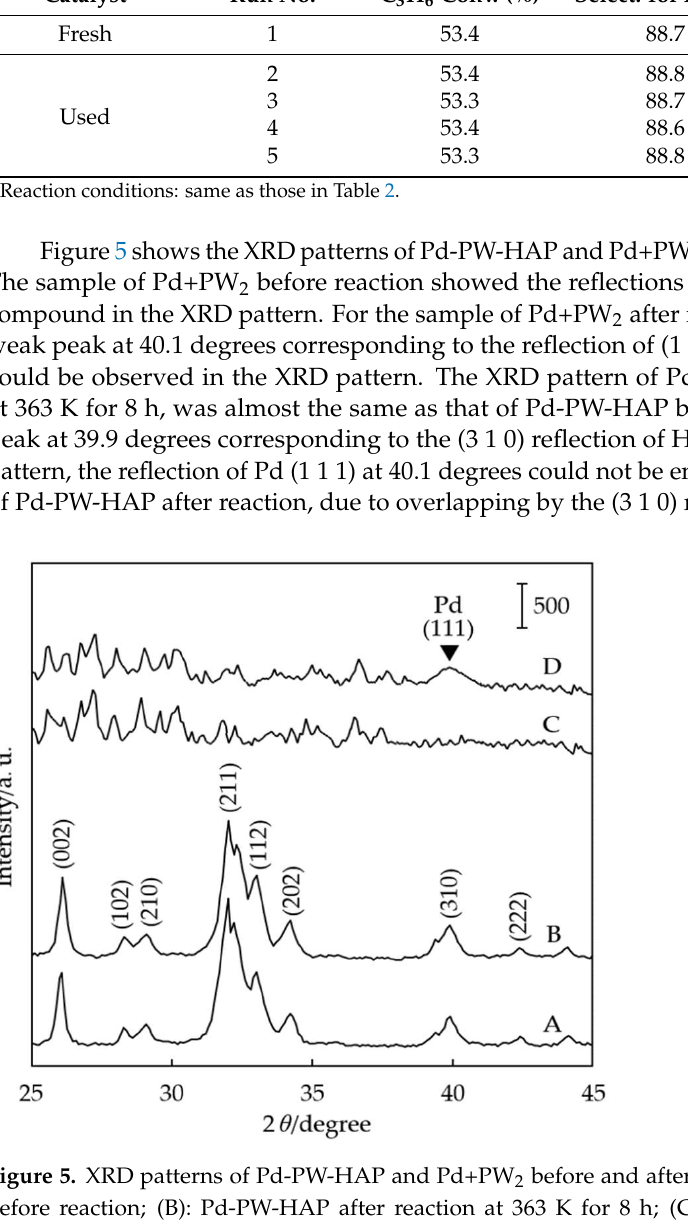
Table 3. Reusability of solid catalyst Pd-PW-HAP for the propylene epoxidation by O 2 in methanol 1 . Catalyst